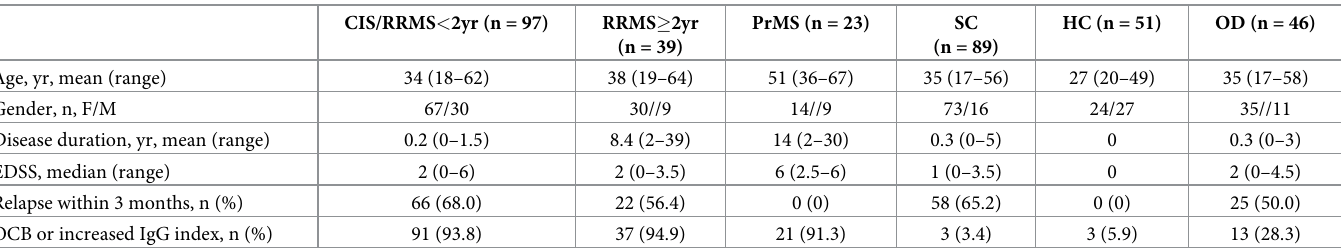
Table 1. Characteristics of the patients and controls.